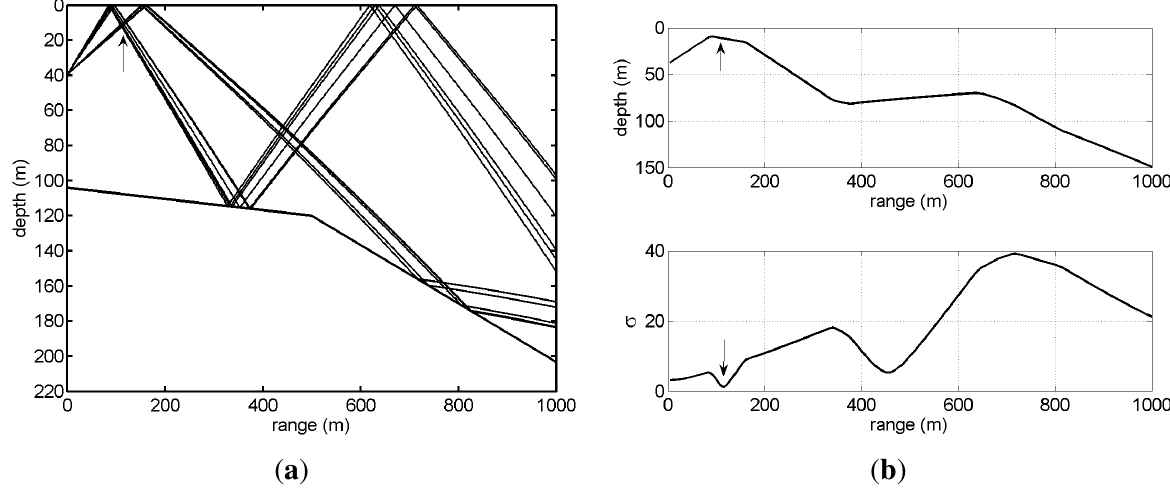
Figure 9. Makai’05 source range-depth estimation at min 57 of the field calibration event considering six sets of backpropagated rays (12 rays) ( a ). The ambiguity curve ( b ) has the minimum (indicated by the arrow) at the 114 m range, lower plot, corresponding to 11.5 m depth in the upper